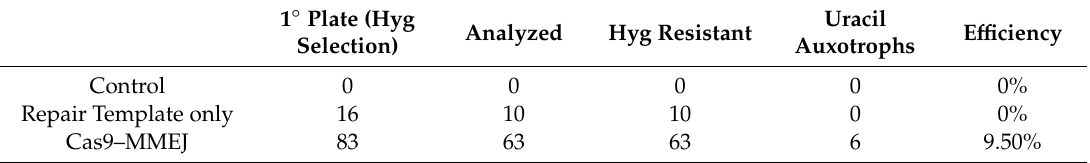
Table 2. Results of the PEG mediated transformation. A subset of hygromycin resistant colonies were subcultured onto various media. Uracil auxotrophs could not grow on media that did not contain uracil. 1 ◦ Plate (Hyg Selection)